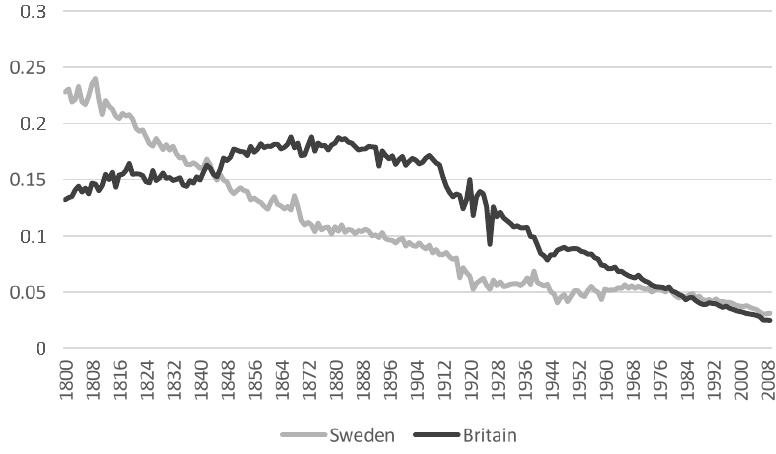
Figure 3. Energy intensity for Britain and Sweden, 1800-2009. Energy consumption divided by real GDP in 1913 price level. GBP are calculated to SEK in 1913 exchange rate. Expressed in GJ/SEK. Sources: energy data: [12]; Swedish GDP: [16]; British GDP: [17,18]; exchange rate: